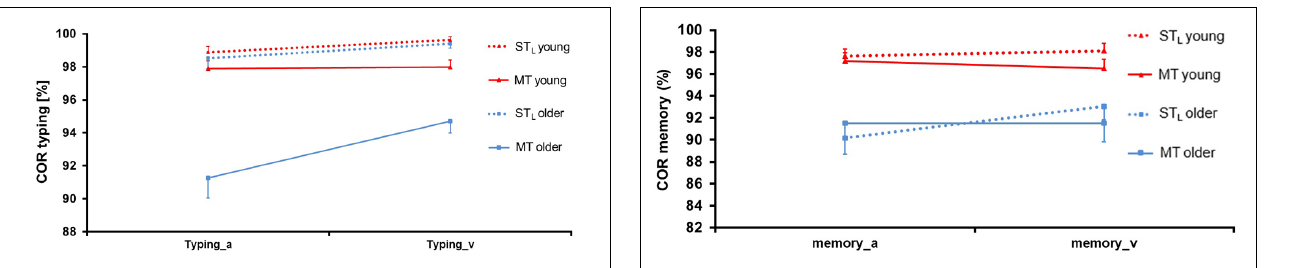
FIGURE 10 | Correctness (COR) ± SE in the typing task for both age groups in single task (ST D ) and multitask (MT) conditions. The typing task was presented auditorily (_a) and visually (_v).